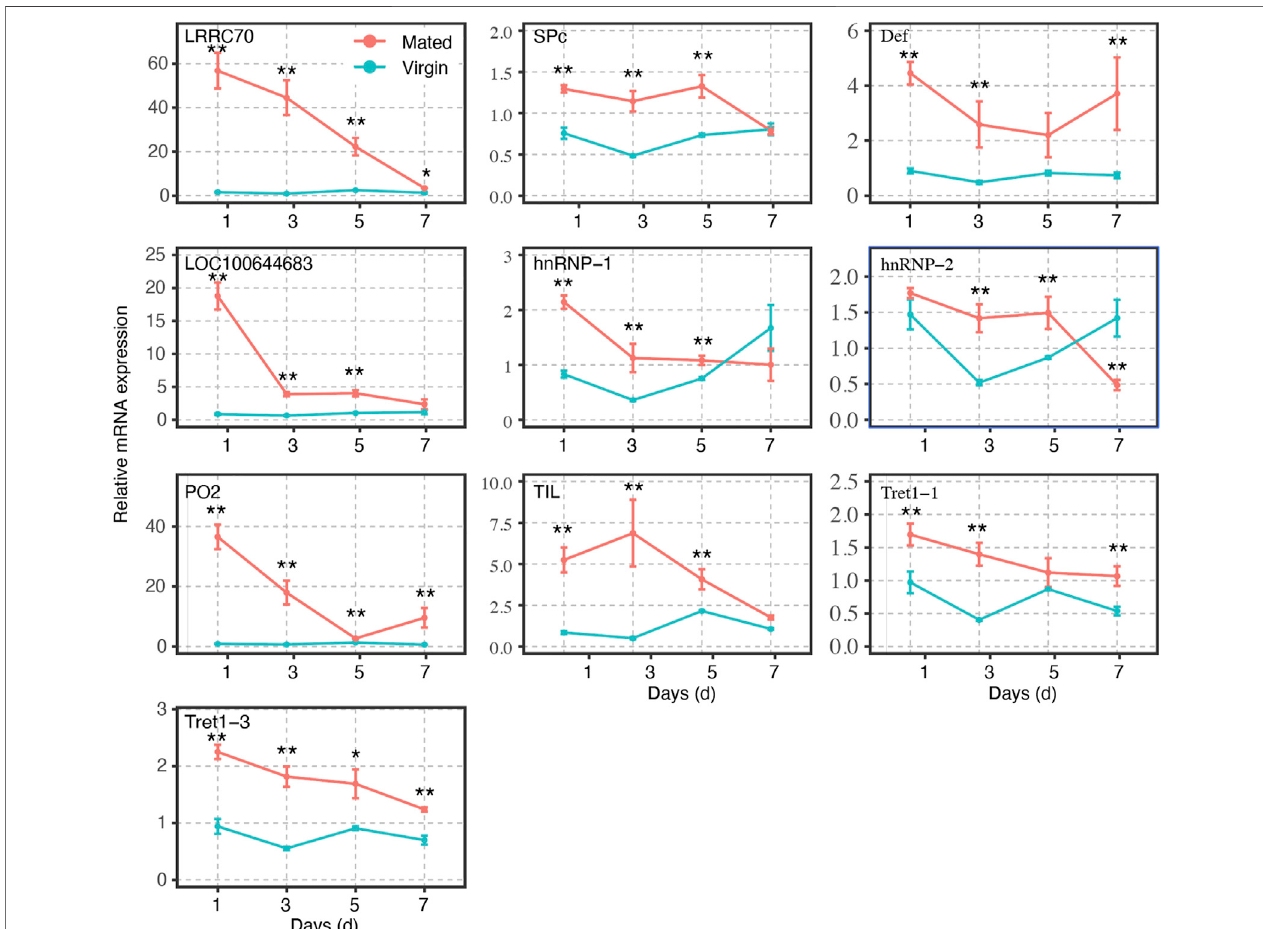
FIGURE 4 | Gene expression pro fi les of selected mating-related DEGs at different time points in mated and virgin bumblebee queens at 1-, 3-, 5-, and 7- days, as determined by RT-qPCR. The expression levels (Mean ± SEM) of selected genes in virgin queens (blue lines) and mated queens (red lines). Asterisks indicate signi fi cant differences between the expression pro fi les of mated and virgin queens. * p < 0.05; ** p < 0.01.